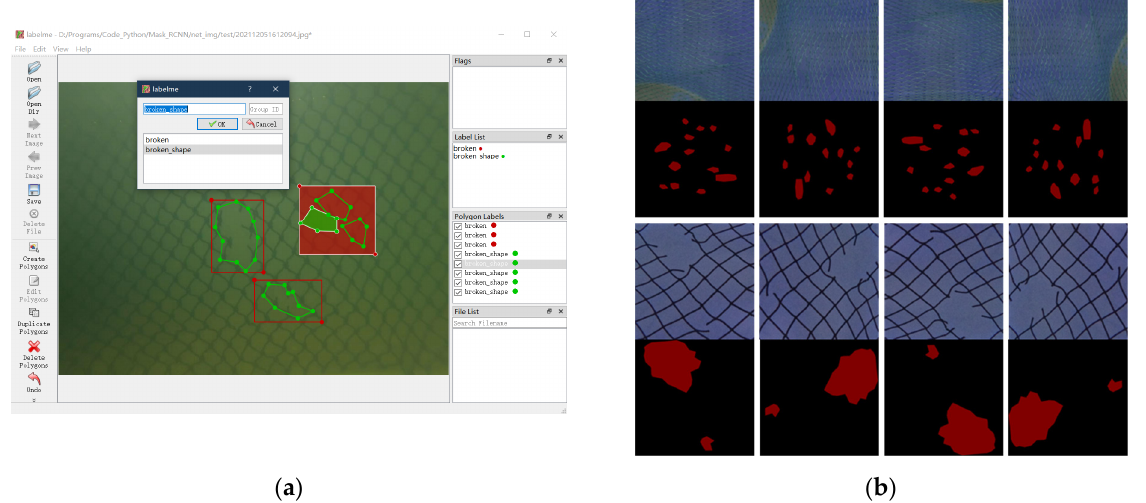
Figure 3. Training dataset labeling on ( a ) LabelMe and ( b ) their mask layers.